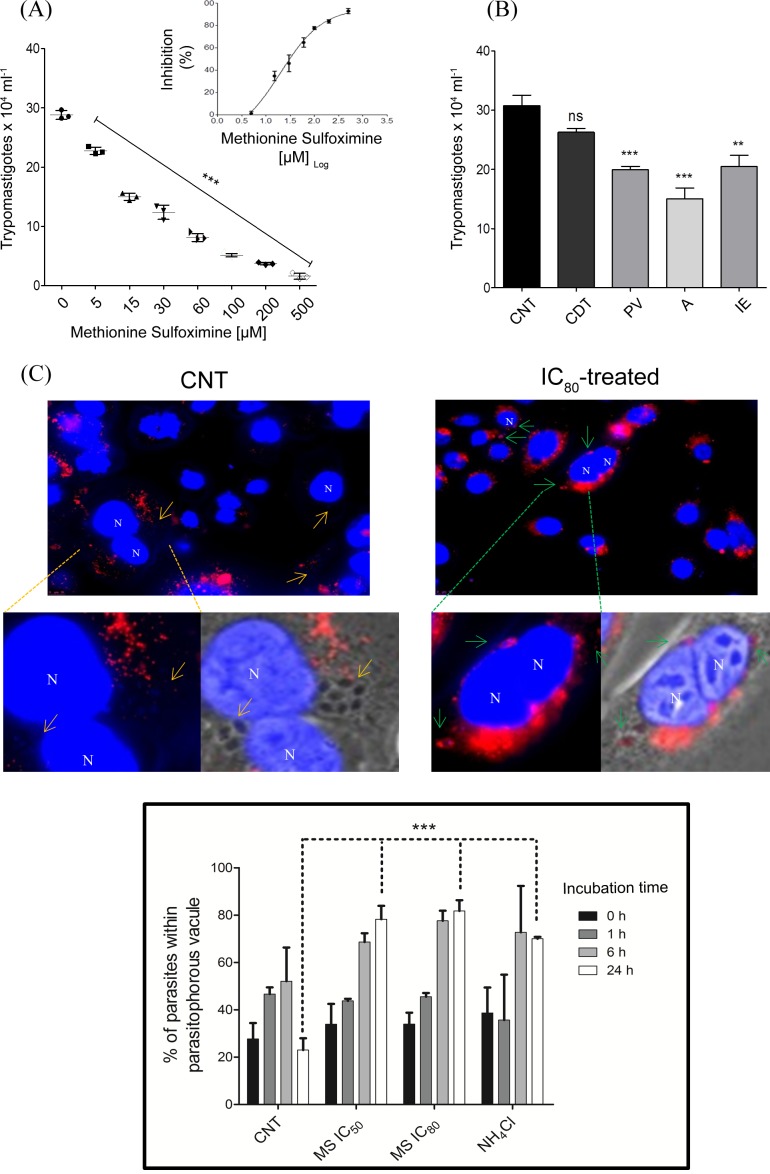
Effect of MS on the intracellular cycle of T. cruzi.(A) The effect of MS on CDT bursting was evaluated by treating the cells throughout the entire infection cycle (concentrations varied between 5 and 500 μM). CDT forms were counted in the culture media at day 5 post-infection. Inset: dose-response curve for the effect of MS treatment on CDT bursting (EC50 = 20.02 ± 0.91 μM). (B) Effect of MS on the different moments of intracellular infection. The mammalian host cells were infected under synchrony conditions in such a way that all infected cells were displaying the same intracellular stages at any moment, as previously described [15]. The infected cells were treated with 20 μM MS (dose corresponding to the EC50) for 3 h during the invasion, for 24 h immediately after invasion (in our system, this time period is when parasites remain inside the parasitophorous vacuole—PV), between 24 and 48 h (intracellular parasites are already in A form in the host-cell cytoplasm) or between 48 and 120 h post-infection (intracellular parasites are in IE form). The measured effect was CDT bursting, which was quantified by counting parasites in a Neubauer chamber. (C) Representative images of the PV of cells treated (or not, as a control) with MS. The assays were performed by labeling CHO-K1 infected cells with LysoNIR. After 3 h of infection the cultures were submitted to a 24-h treatment (or not) with 83 μM MS (corresponding to EC80) and washed. Nuclear DNA (N) was stained with Hoechst 33342. Yellow arrows: example of unlabeled parasites; green arrows: example of labeled parasites. Bottom: the total number of parasites and number of parasites labeled with LysoNIR 200 cells were counted and used to calculate the percentage of parasites within the PV at different times post-infection. Statistical analysis were made using one-way ANOVA / Dunnet’a Multiple Comparision Test. *p<0.05, **p<0.01, ***p<0.001, Error bars represent standard deviation (n = 3).